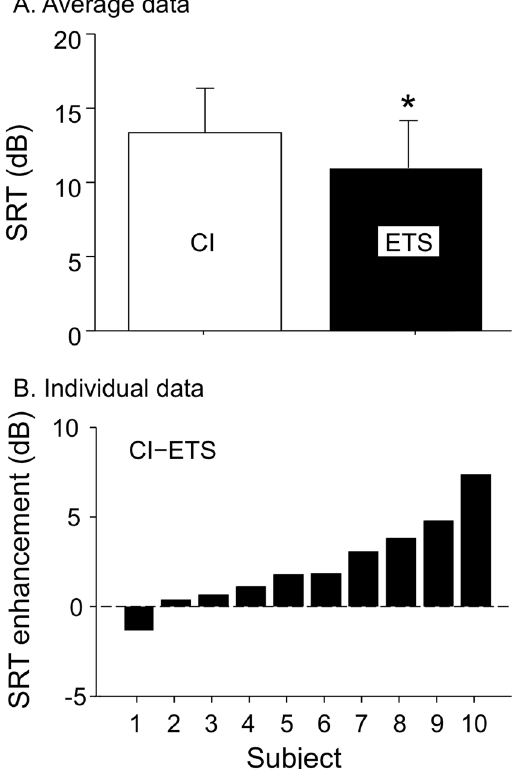
Figure 1. ( A ) Average speech reception threshold (SRT) between the cochlear implant only condition (CI: open bar) and the combined electro-tactile stimulation (ETS: filled bar). The error bars represent one standard deviation of the mean. The asterisk indicates a significant improvement of the ETS condition over the CI condition. ( B ) Individual enhancement in terms of the SRT difference between the CI and ETS conditions, ranked from low (Subject 1) to high (Subject